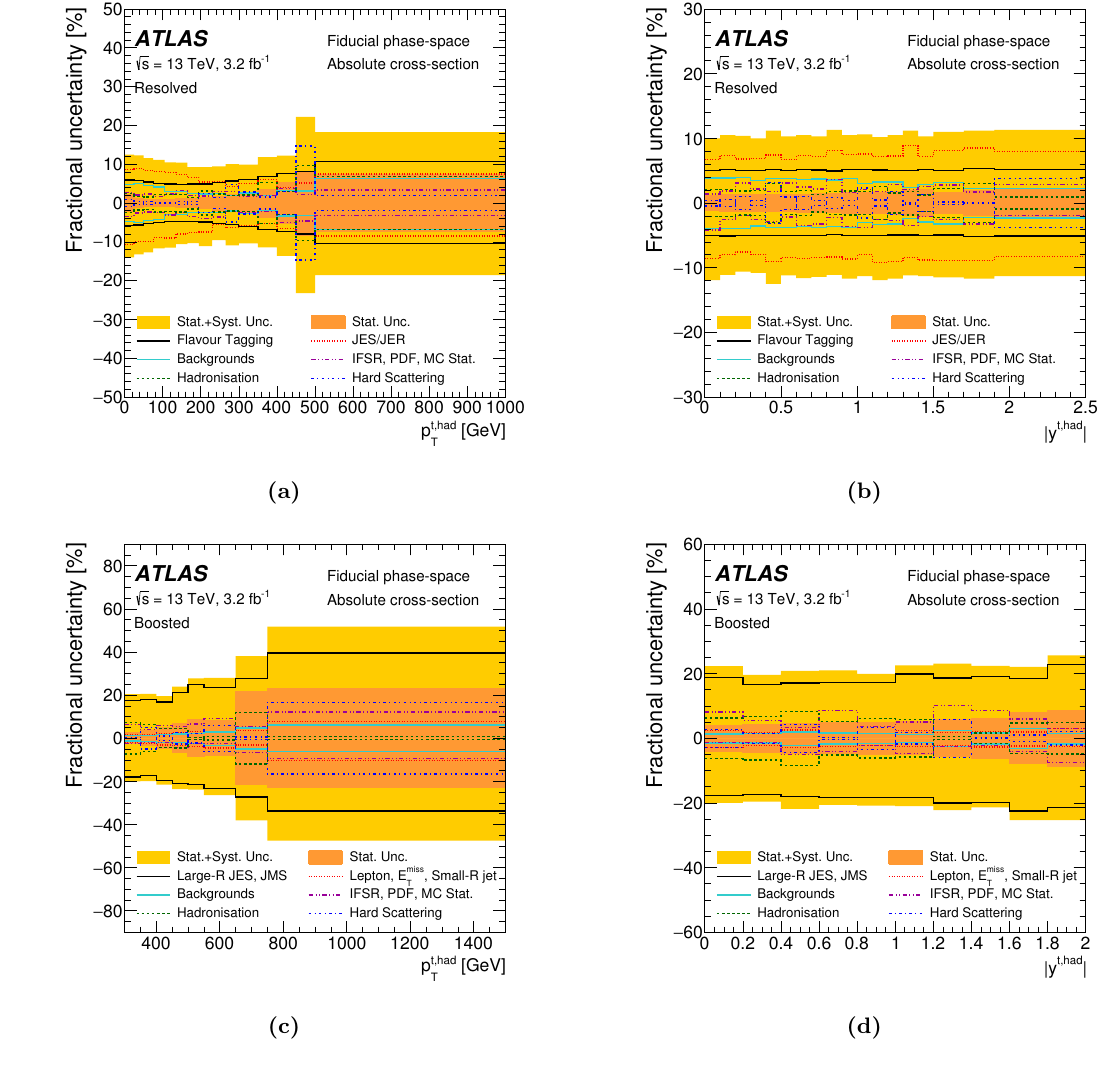
Figure 11. Uncertainties in the (cid:12)ducial phase-space di(cid:11)erential cross-sections as a function of (a) the transverse momentum ( p t; had ) and (b) the absolute value of the rapidity ( T the hadronic top quark in the resolved topology and corresponding results in the boosted topol- ogy (c), (d). The yellow bands indicate the total uncertainty of the data in each bin. The Powheg + Pythia6 generator with h damp = m t and the CT10 PDF is used as the nominal prediction to correct for detector